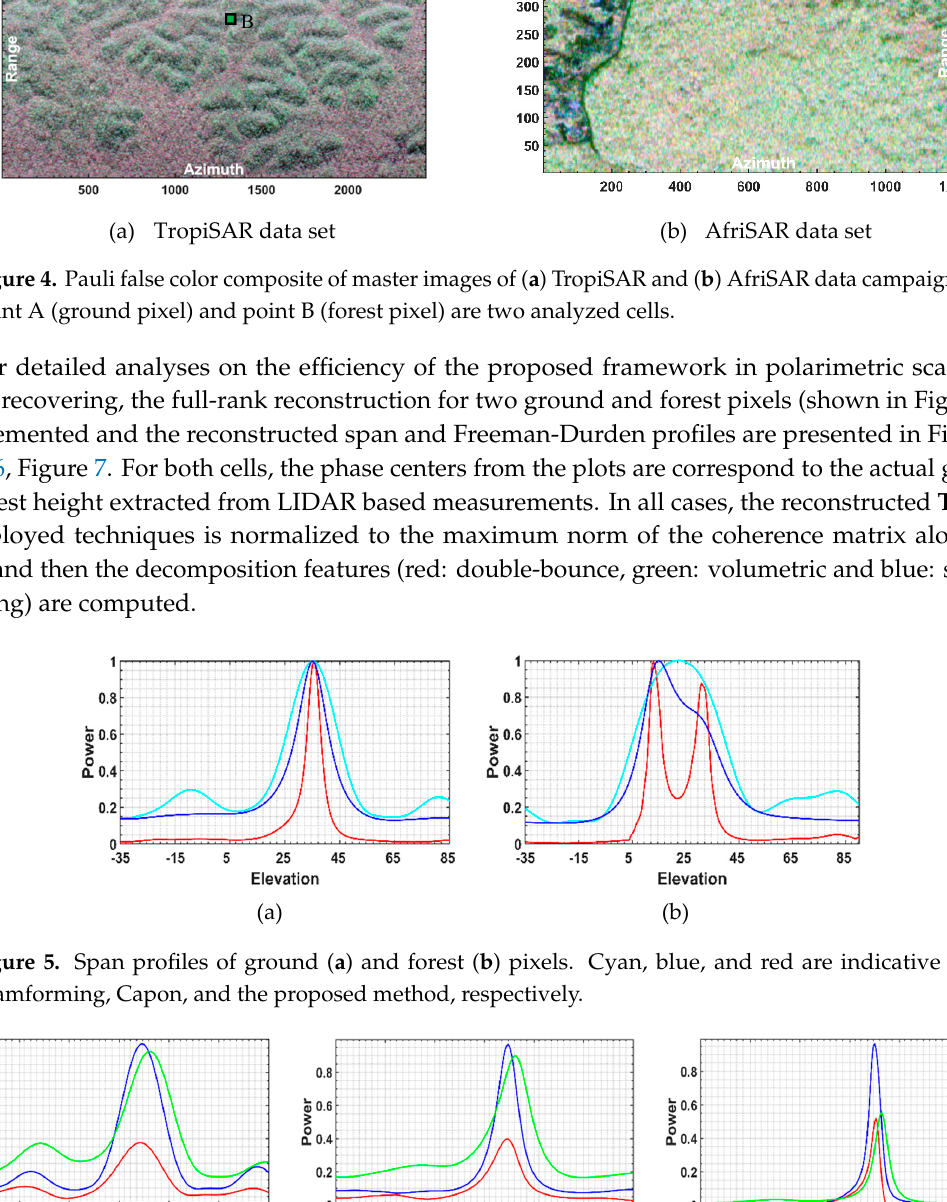
Figure 6. Extracted three-component features of ground pixel (shown in Figure 4 a ) from reconstructed T using ( a ) Beamforming, ( b ) Capon, and ( c ) the proposed method. Red, green and blue indicate the double-bounce, volumetric and surface scattering mechanisms.